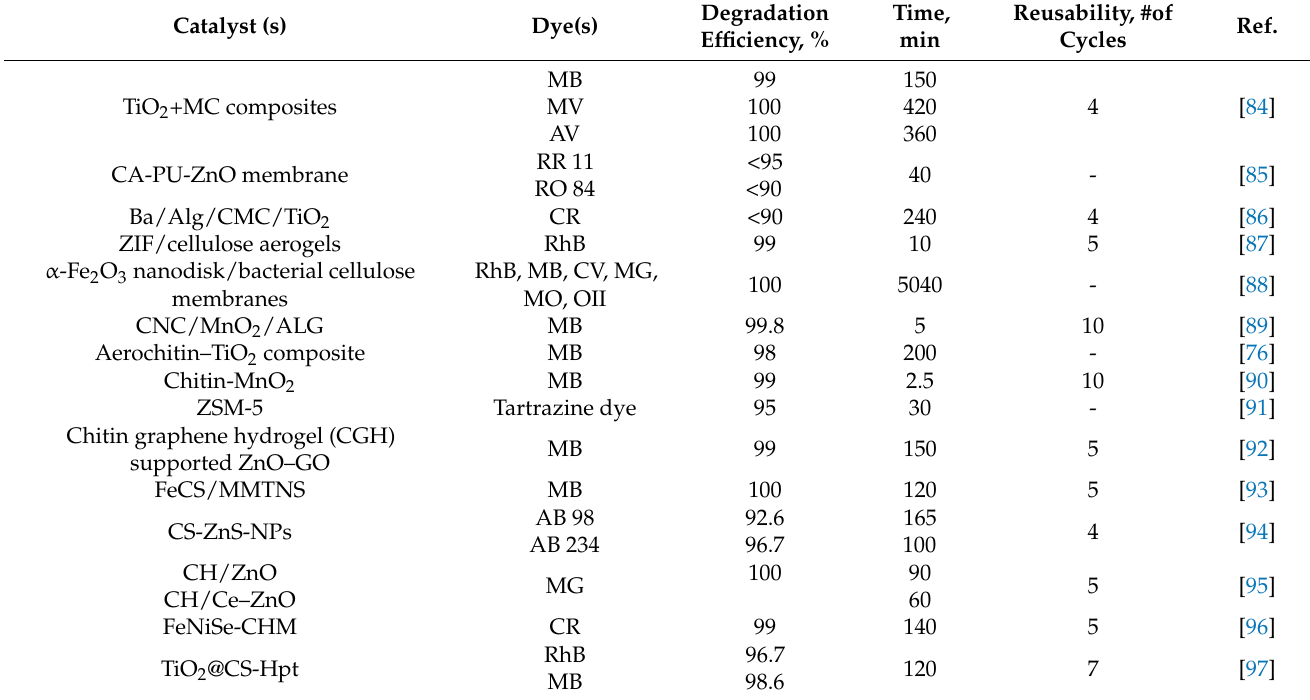
Degradation Time, Reusability, #of Efficiency, % min Cycles